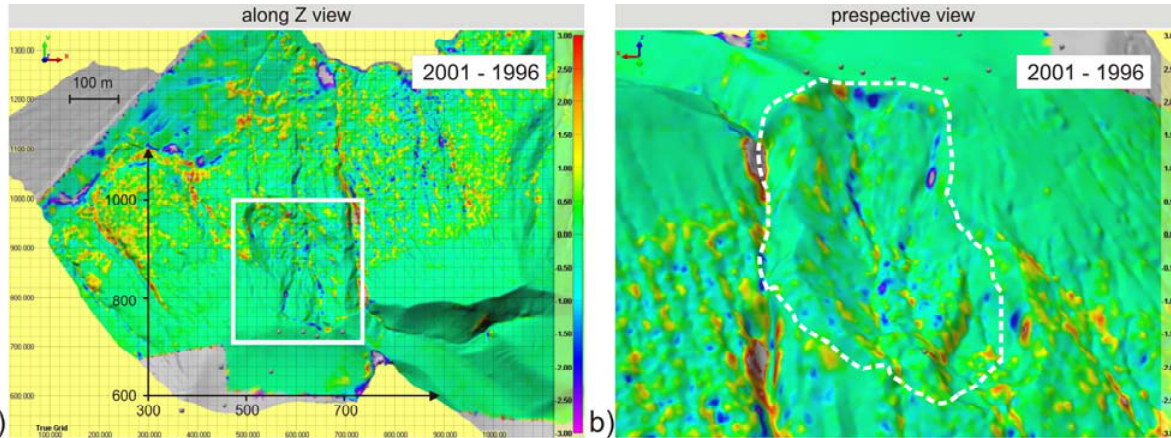
Figure 5. Comparison between registered digital models. ( a ) 1996–2001 horizontal displacements rendered from the DTM seen from the vertical direction. ( b ) 1996–2001 vertical displacements of the La Fossa cone, seen as a perspective view from about N direction ( y -axis). ( c ) 2001–2009 horizontal displacements. ( d ) 2001–2009 vertical